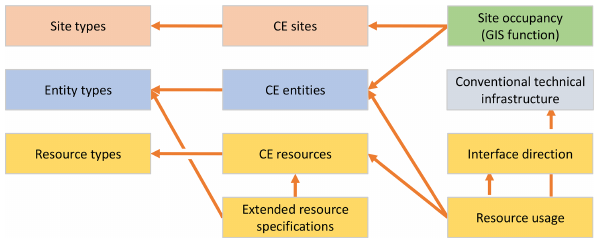
Figure 2. Core CE information model, arrow direction indicates access to model